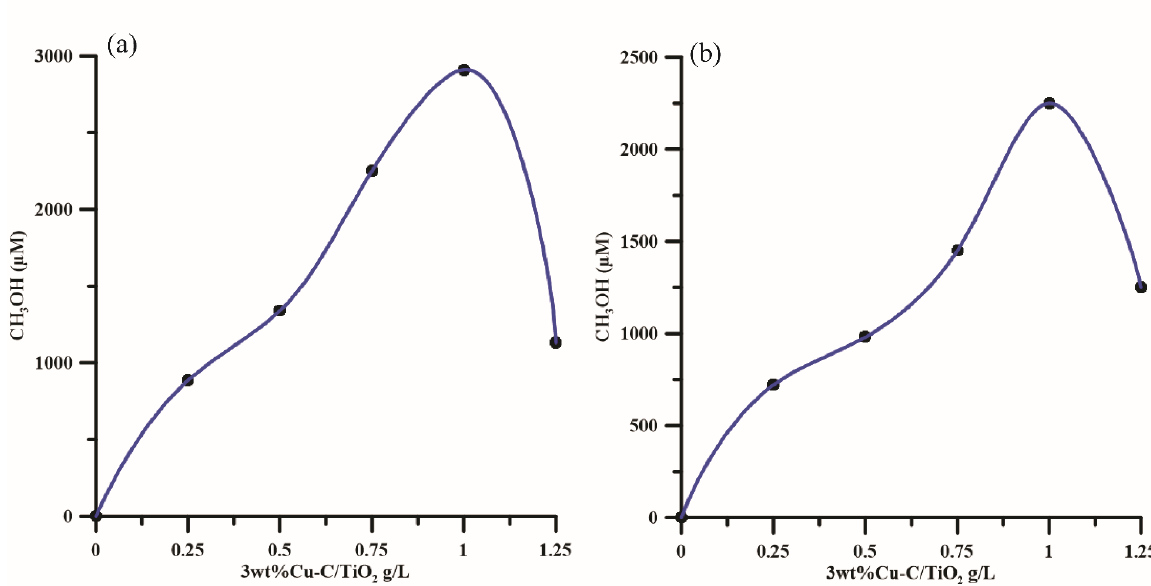
Figure 4. The effect of dosage of 3wt% Cu-C/TiO Figure 4: The effect of dosage of 3wt% Cu-C/TiO